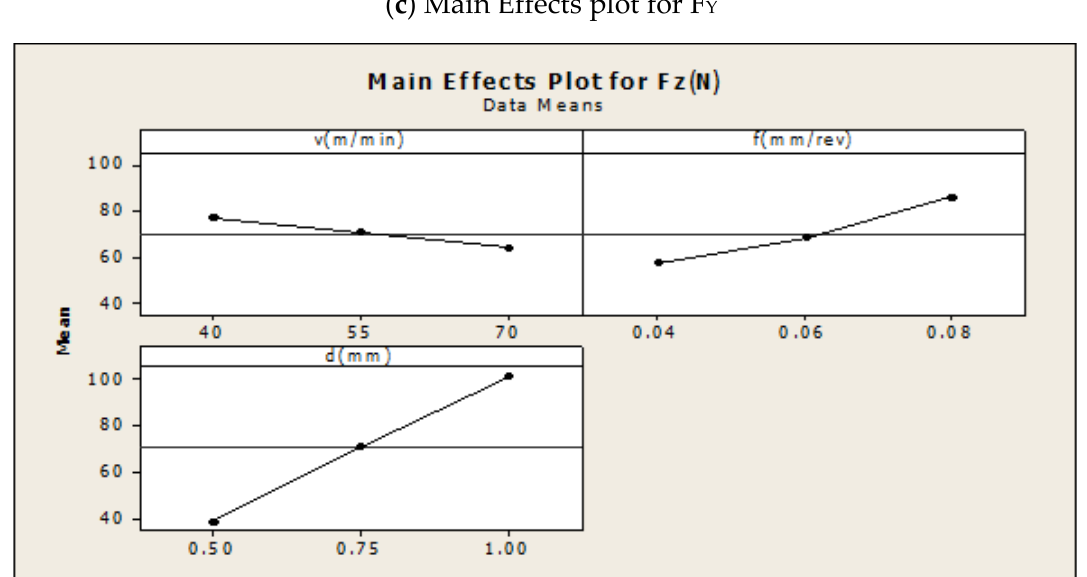
( c ) Main Effects plot for F Y